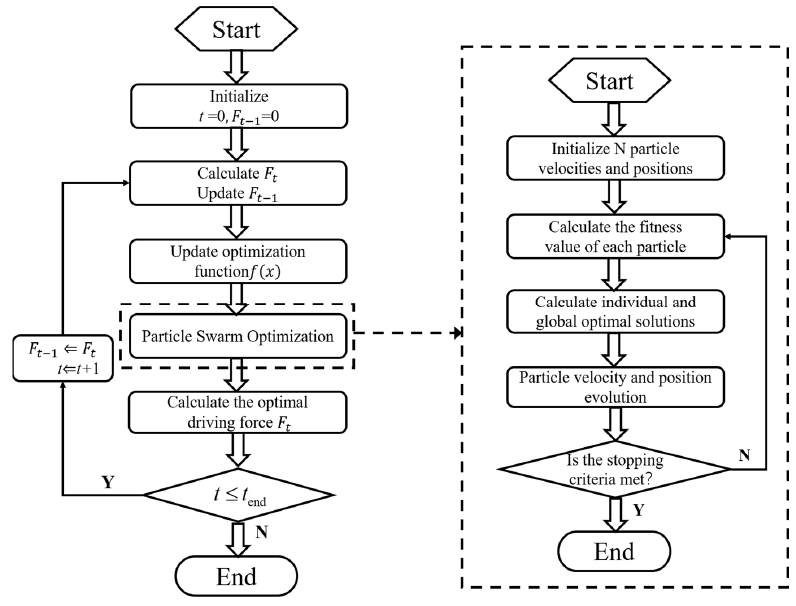
Figure 3. Flowchart of particle swarm optimization (PSO).